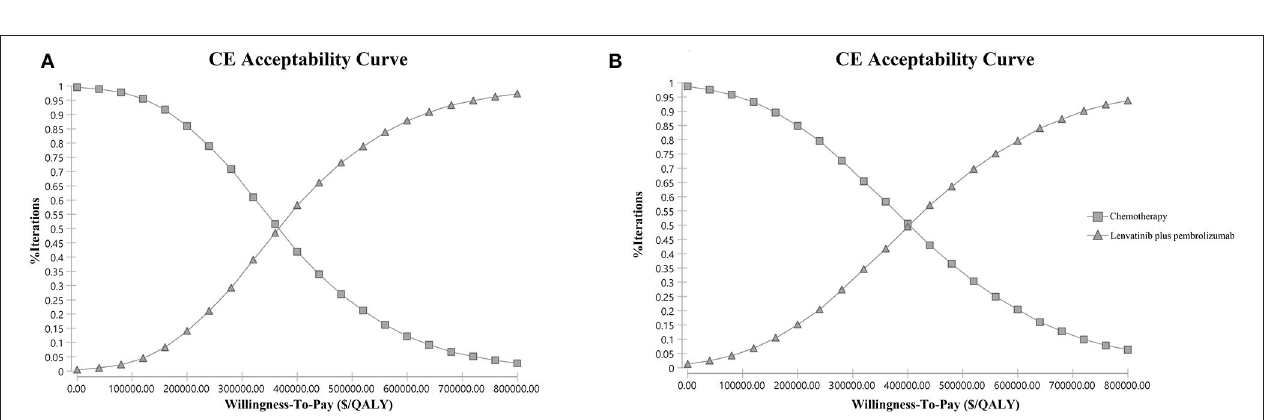
FIGURE 2 | Tornado diagram. The tornado diagram shows the one-way sensitivity analyses within the appropriate range for each variable. ICER, incremental cost-effectiveness ratio; PFS, progression-free survival; PD, progressive disease; WBC, white blood cell; dMMR, mismatch repair–deficient; MSI-H, microsatellite instability–high; QALY, quality-adjusted life year; EV, expected value.